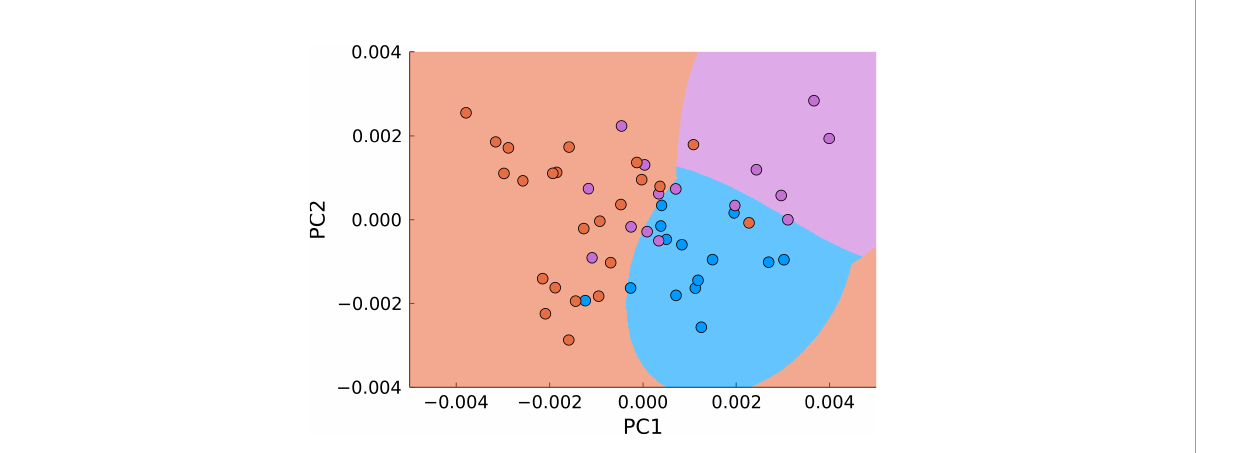
FIGURE 8 PCA of pre- fi ltered data (blue – normal tissue, magenta - tumor edge, orange - tumor center). The background color signi fi es the classi fi cation by